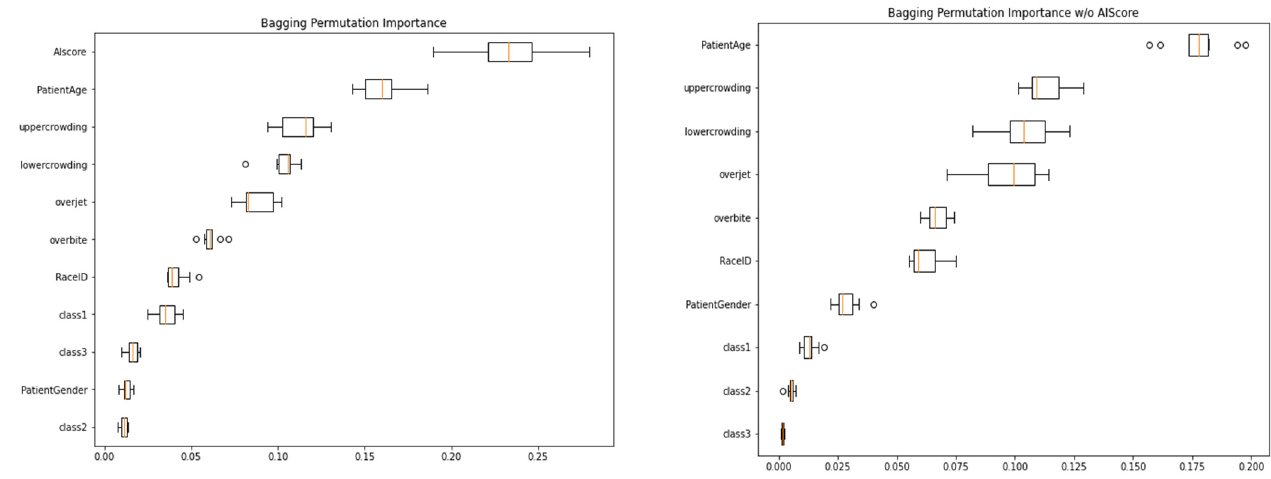
Figure 6. Feature importance for the Bagging model.